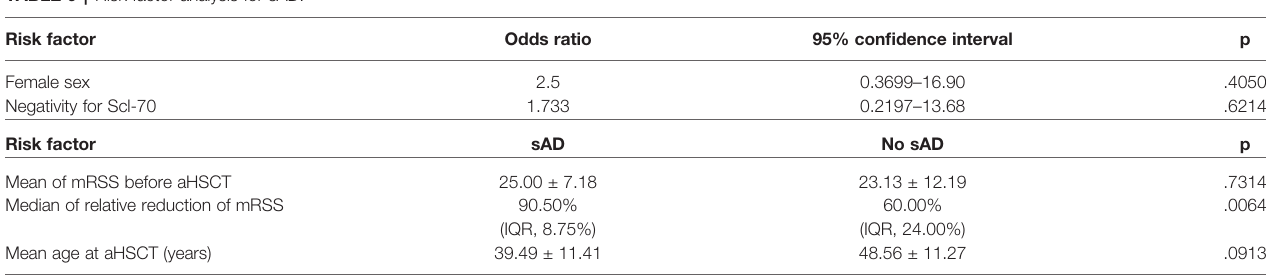
Risk factor analysis for secondary autoimmune disorders. For metric scaled variables, means ± standard deviation or medians with interquartile range (IQR) are shown. Ordinal scaled variablesarepresentedasoddsratiowith95%con fi denceinterval.AhighermedianmRSSreductionbyaHSCTwasfoundinthegroupwithonsetofsAD.Theotherinvestigatedvariables showed no signi fi cant differences between the two groups. sAD, secondary autoimmune disorders; mRSS, modi fi ed Rodnan skin score; aHSCT, autologous hematopoietic stem cell